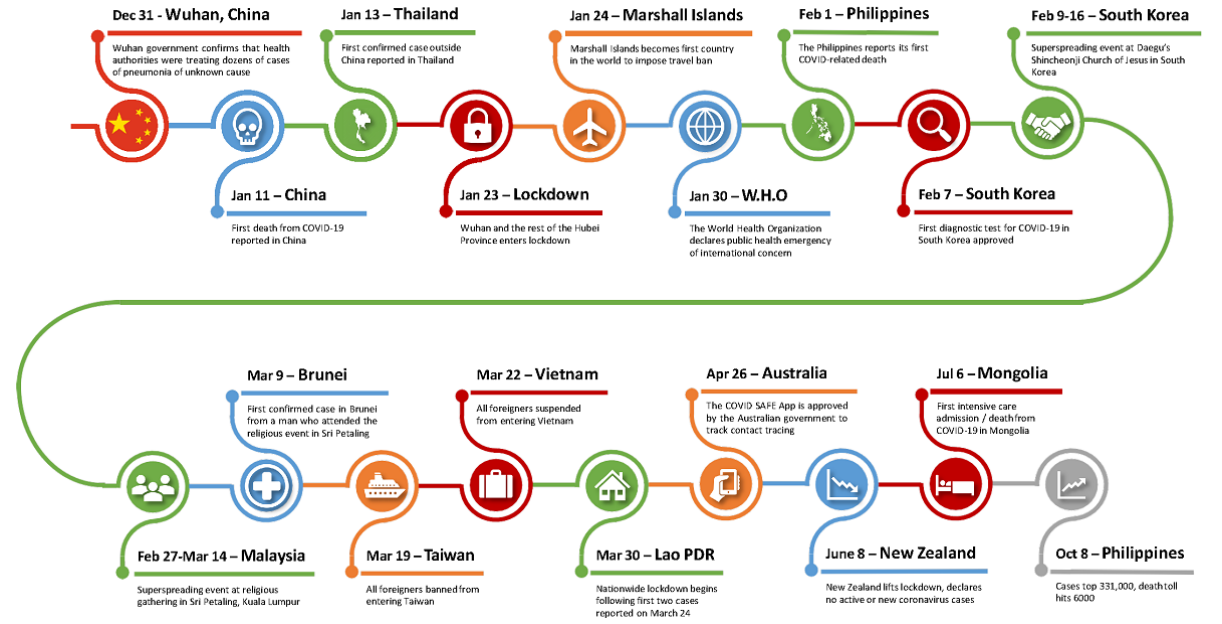
Figure 1. COVID-19 timeline in East Asia and the Pacific. WHO: World Health Organization. PDR: People's Democratic